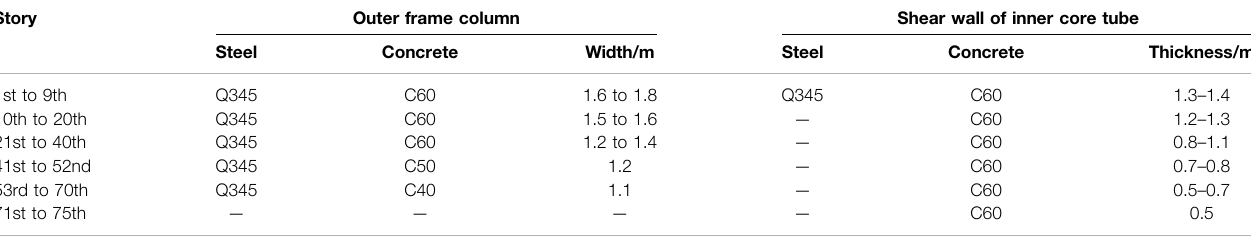
TABLE 1 | Information of main structural